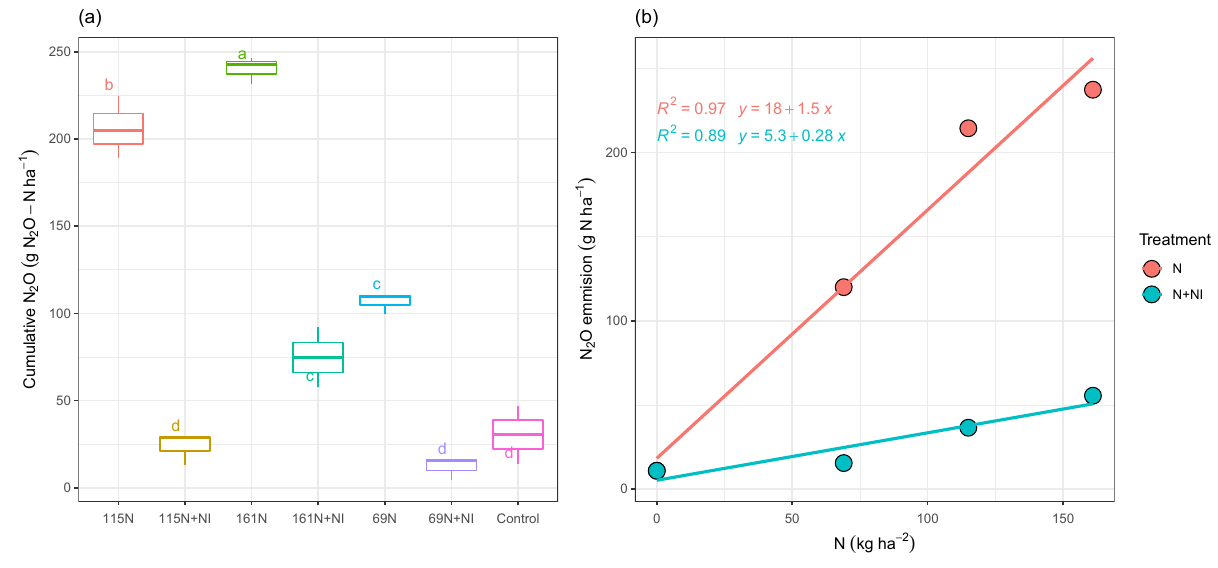
Figure 2. Cumulative N 2 O emission ( a ) and N 2 O emission versus N rates ( b ) at the different levels of N application and with or without NI during the maize growth season in 2018. Means with the same letters are not significantly different according to the least significant difference (LSD) at p < 0.01, n =